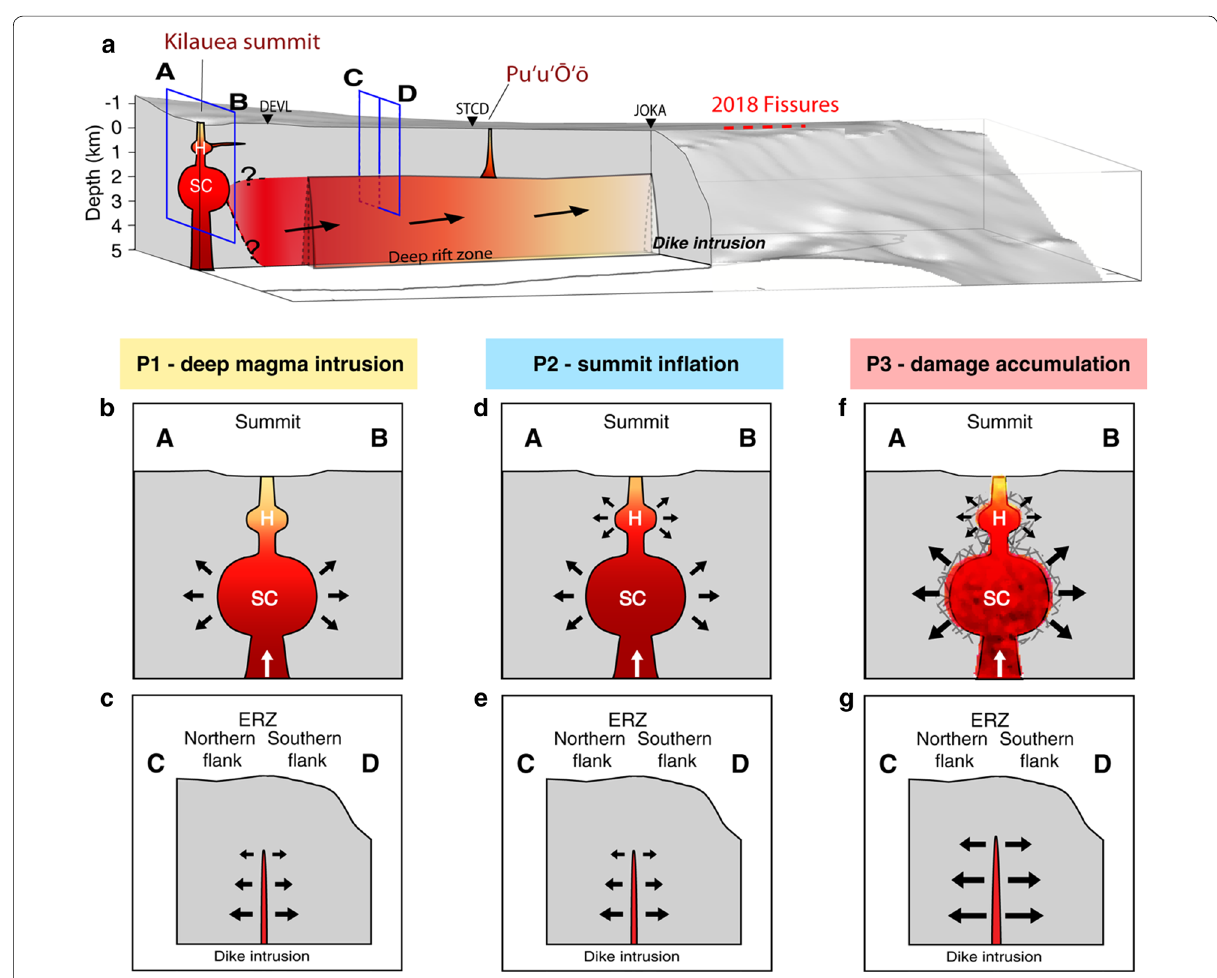
Fig. 9 Schematic model of proposed magmatic processes prior to the 2018 eruption. a 3‑D illustration of magmatic reservoir‑dike system in the Kilauea area. b Cross‑section A–B and c C–D illustrate the time evolution of proposed processes at the summit and across the UERZ in the three periods as blue boxes in a . H, Halema ʻ uma ʻ u reservoir; SC, Southern caldera reservoir. P1, P2, and P3 denote the time periods of deep magma intrusion, summit inflation, and damage accumulation of edifice. Please refer to the details in the